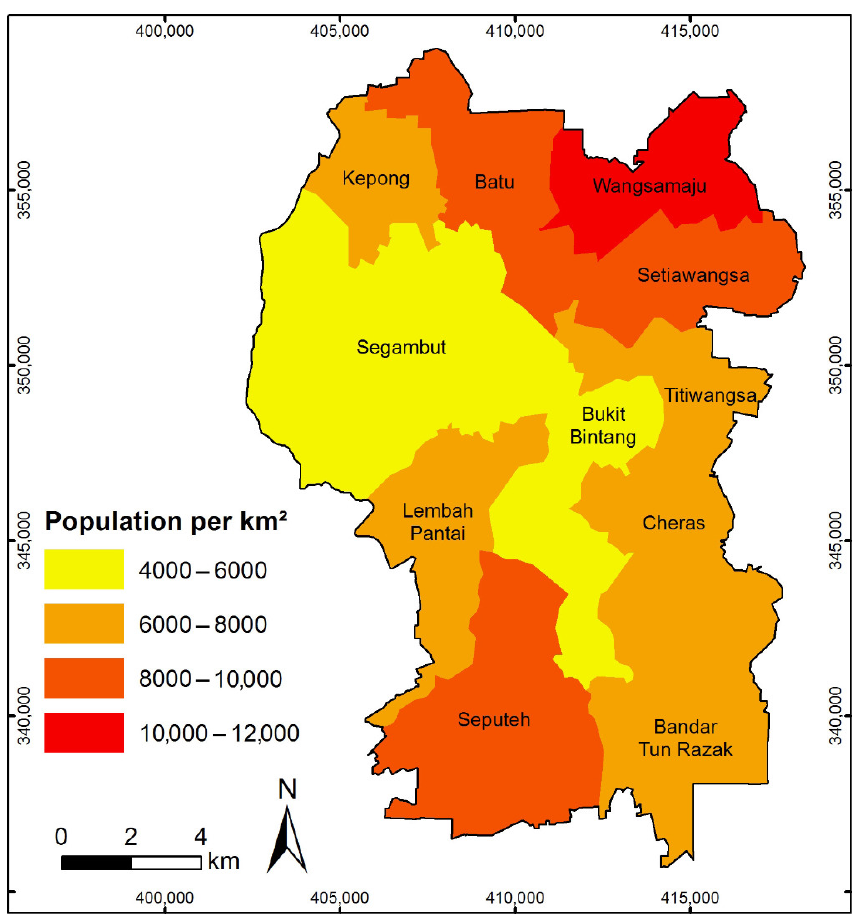
Figure 6. Population density map of Kuala Lumpur at district level based on 2020 census data.